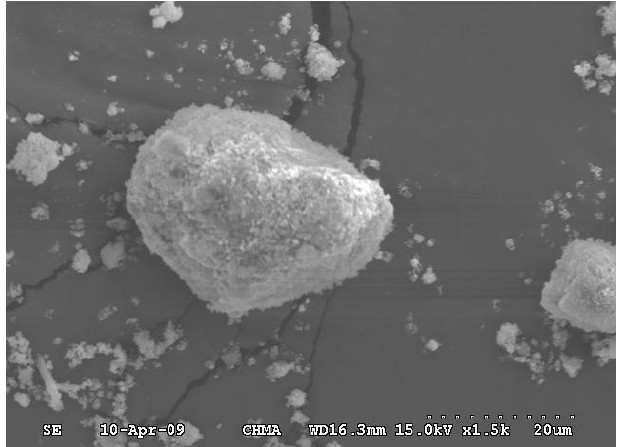
Figure 5. Scanning electron microscope (SEM) photograph (magnifications: 1500×) of the optimal calcite-based powder